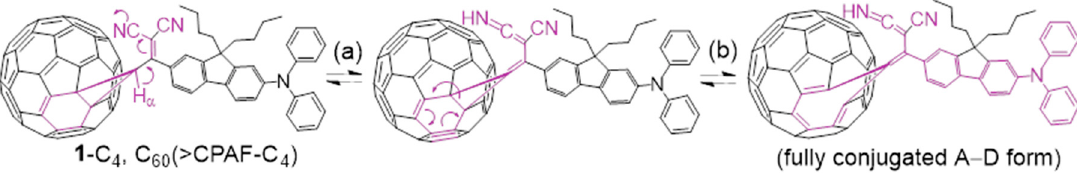
Figure 1. ( a ) Endinitrile tautomeric resonances at the bridging C 61 H α -C[=C(CN) 2 ] structure of a C 60 -CPAF conjugate compound 1 -C 4 and ( b ) fullerenyl seven-membered ring expansion involving C 61 , leading to the formation of a fully-conjugated form of C 60 > acceptor ( A ) and CPAF donor ( D ), as marked in purple. This resulted in an extended A – D conjugation length and absorption wavelengths, marked in burgundy red in color.